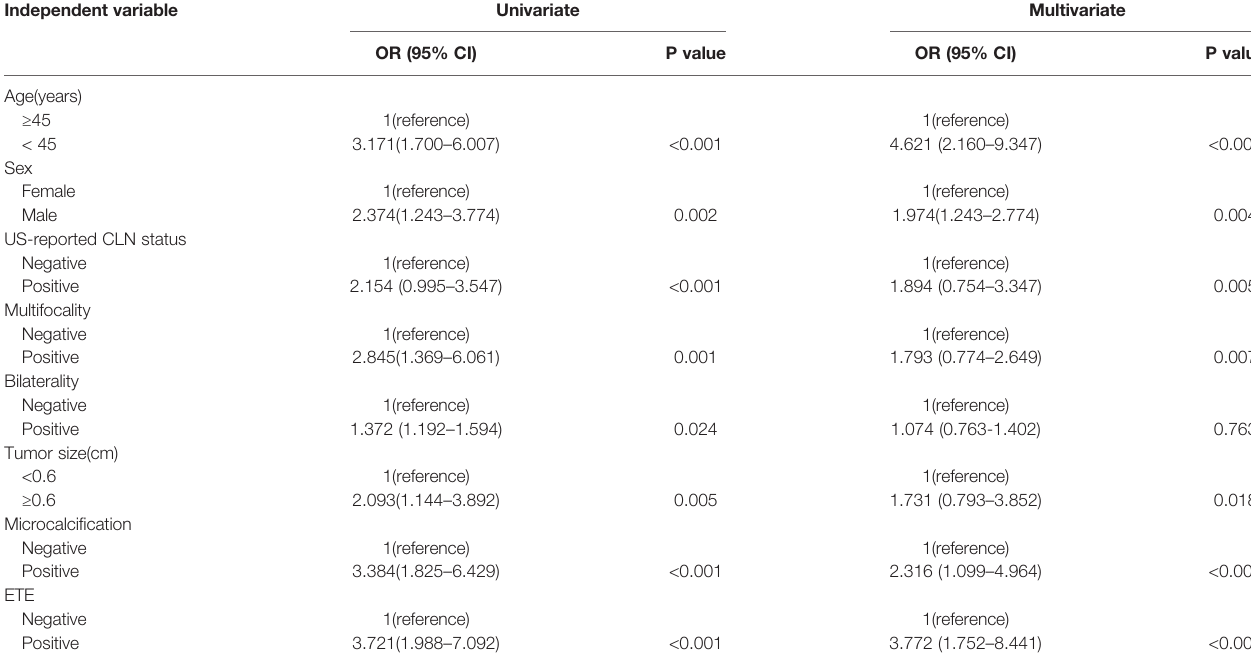
TABLE 2 | Univariate and multivariate analysis of 552 PTMC primary sites with clinical and US features for predicting CLNM.